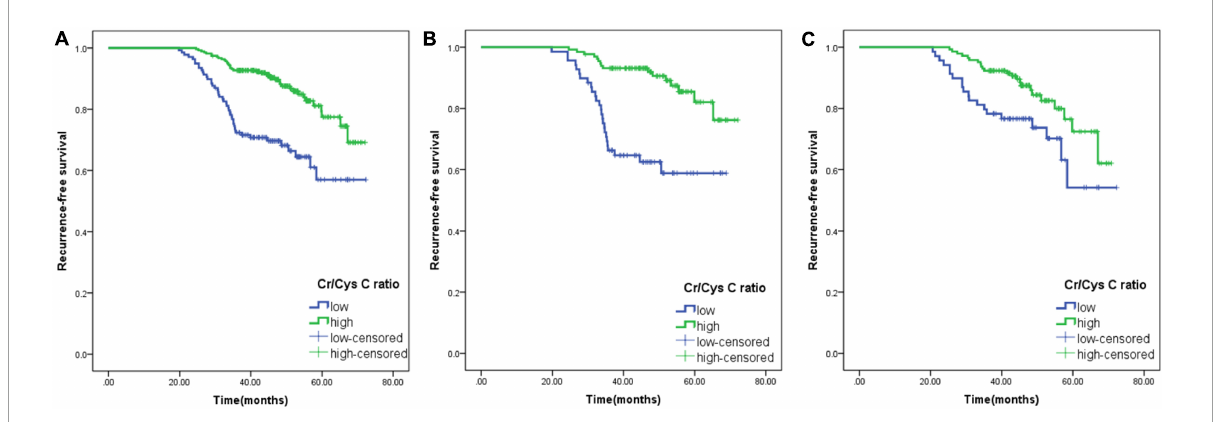
FIGURE2 Comparison of the prognosis of patients with low and high serum creatine (Cr)/cystatin C (CysC) ratios. (A) , All patients; (B) , Male patients; (C) , Female patients. Cr/CysC < 0.65 was defined as low Cr/CysC; Cr/CysC > 0.65 was defined as high